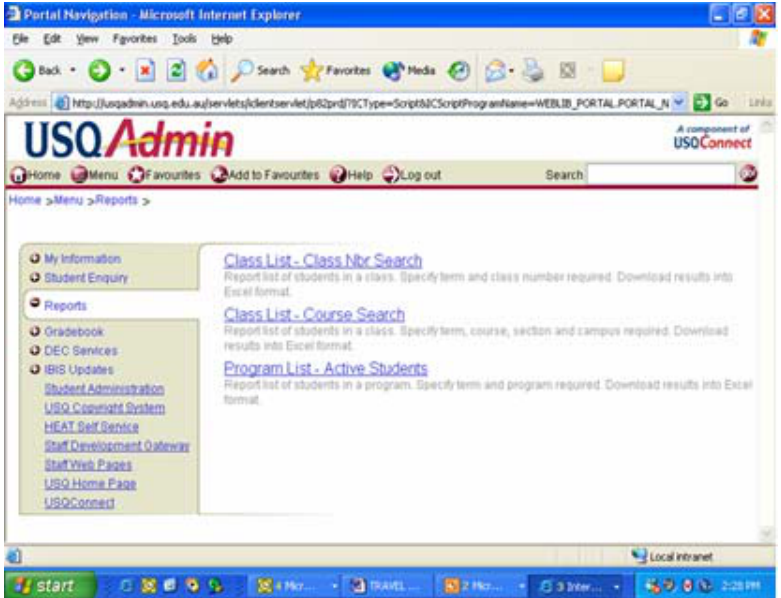
Figure 2. USQAdmin